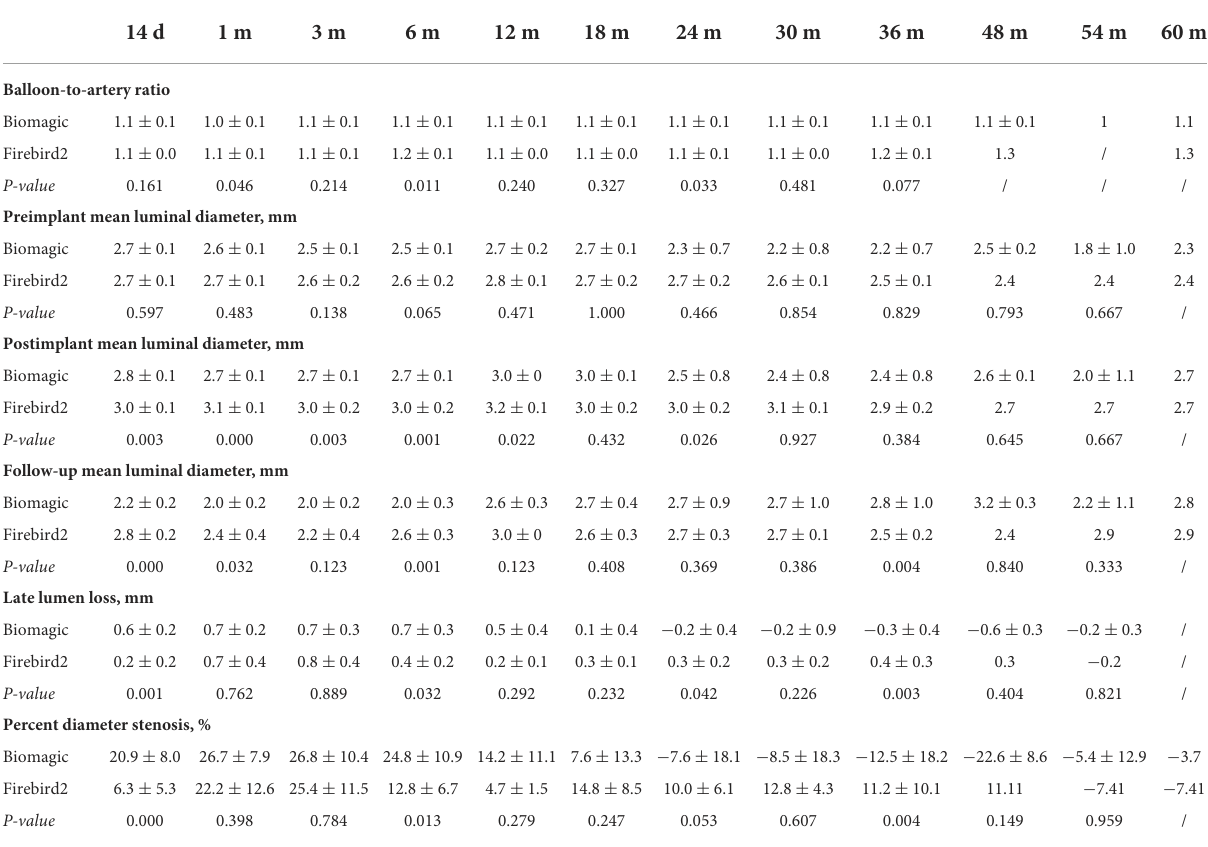
TABLE 1 Quantitative coronary